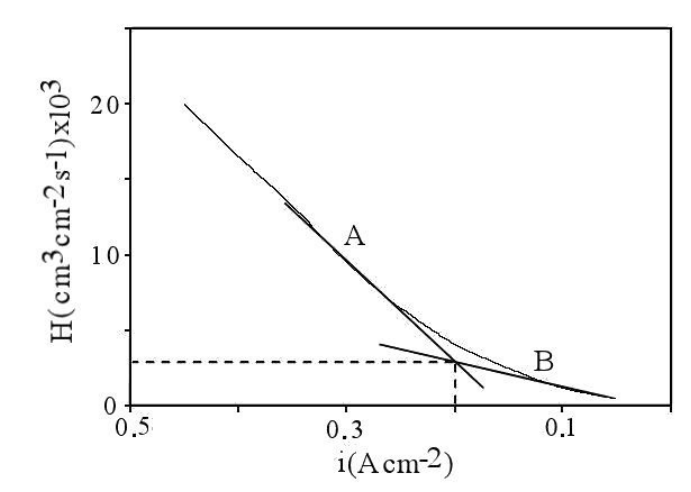
Figure 8. Influence of cathodic current on permeability, (A): near reversible potential for hydrogen launching in deep penetration; (B): near equilibrium potential in subsurface with palladium